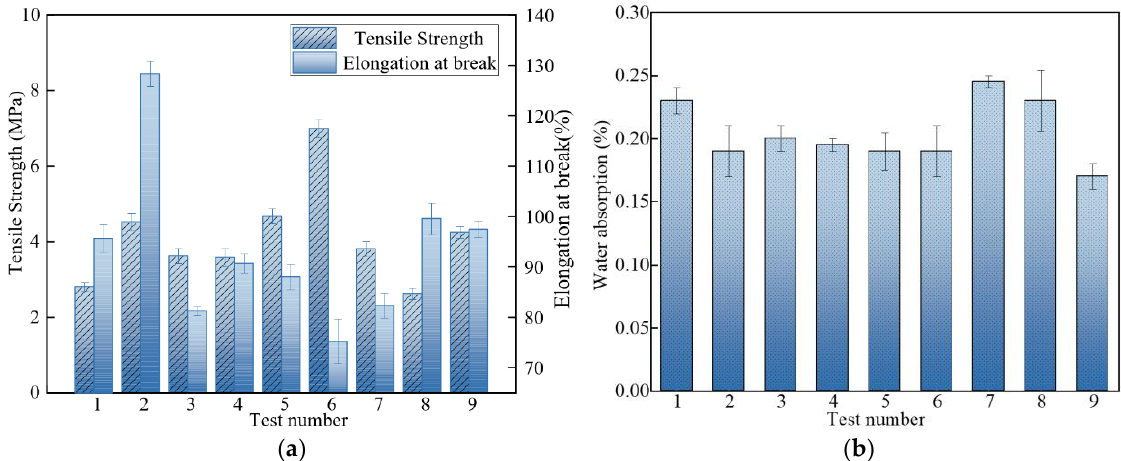
Figure 3. Mechanical and physical properties of different groups of PU-ER: ( a ) Tensile strength and elongation at break; ( b ) Water